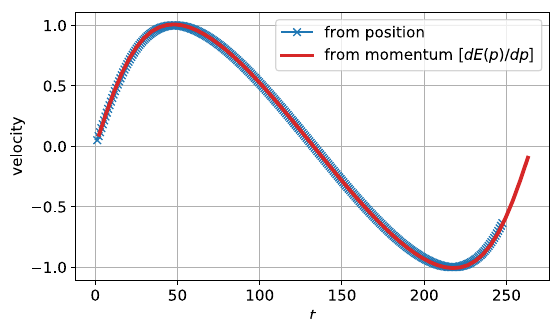
FIG. 6. Evolution of the kink velocity, relative to its maximum value, for the single-kink simulation of Fig. 5, computed from the projection of the wavefunction into the | κ j (cid:3) position basis in two different ways: from finite differences of the position expec- tation value and from the momentum expectation value, via the numerical dispersion relation E ( p ) . That there is a good match shows that the kink-quasiparticle ansatz accurately captures the confined quasiparticles present in the Z 2 -broken Ising